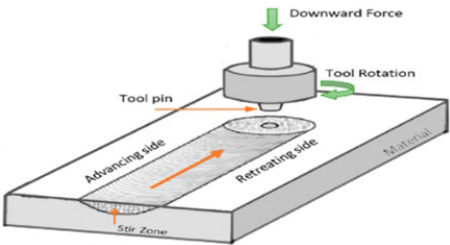
Figure 6. Schematic illustrations of the friction stir process reprinted from [26].